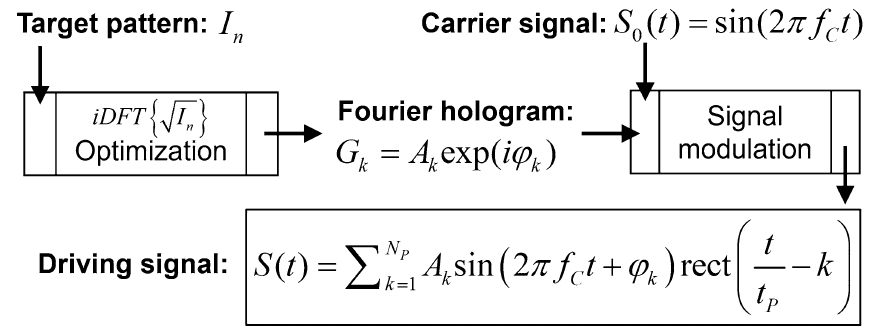
Figure 7. Calculation of the holographic driving signal. The Fourier hologram is calculated with an inverse Fourier transform of the target pattern I n . An iterative algorithm optimizes the hologram diffraction efficiency. The amplitude and phase of the hologram are encoded in the carrier signal, taking into account the size of the AOD aperture L and the number of hologram sample points N P